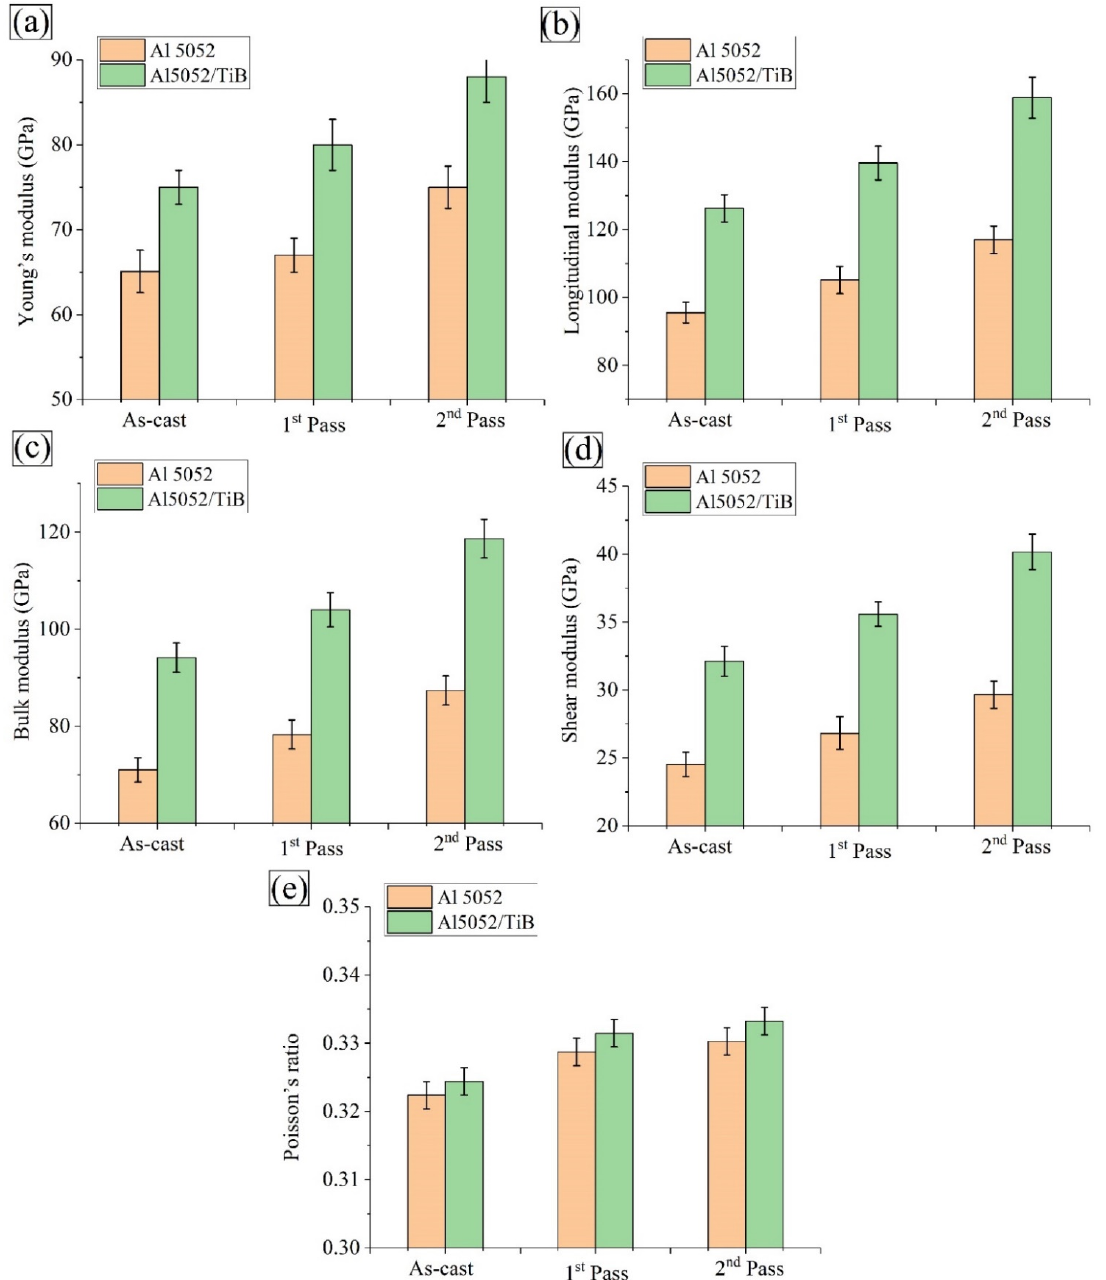
Figure 13. Elastic moduli of Al 5052 and Al 5052/TiB samples: (a) young’s modulus, (b) longitudinal modulus, (c) bulk modulus, (d) shear modulus and (e) Poisson’s ratio.